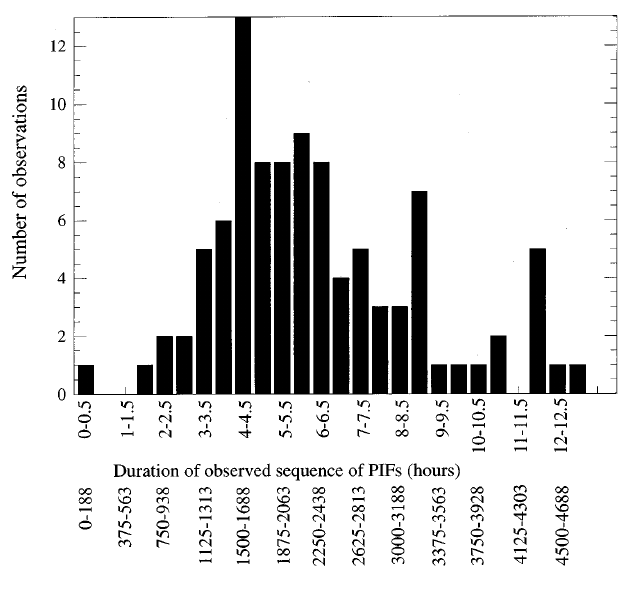
Fig. 9. Azimuthal extent of the sequence of PIFs in MLT and the equivalent size in km, calculated from observations made using the entire f.o.v of the CUTLASS Finland radar when run in a normal scan mode (see text for